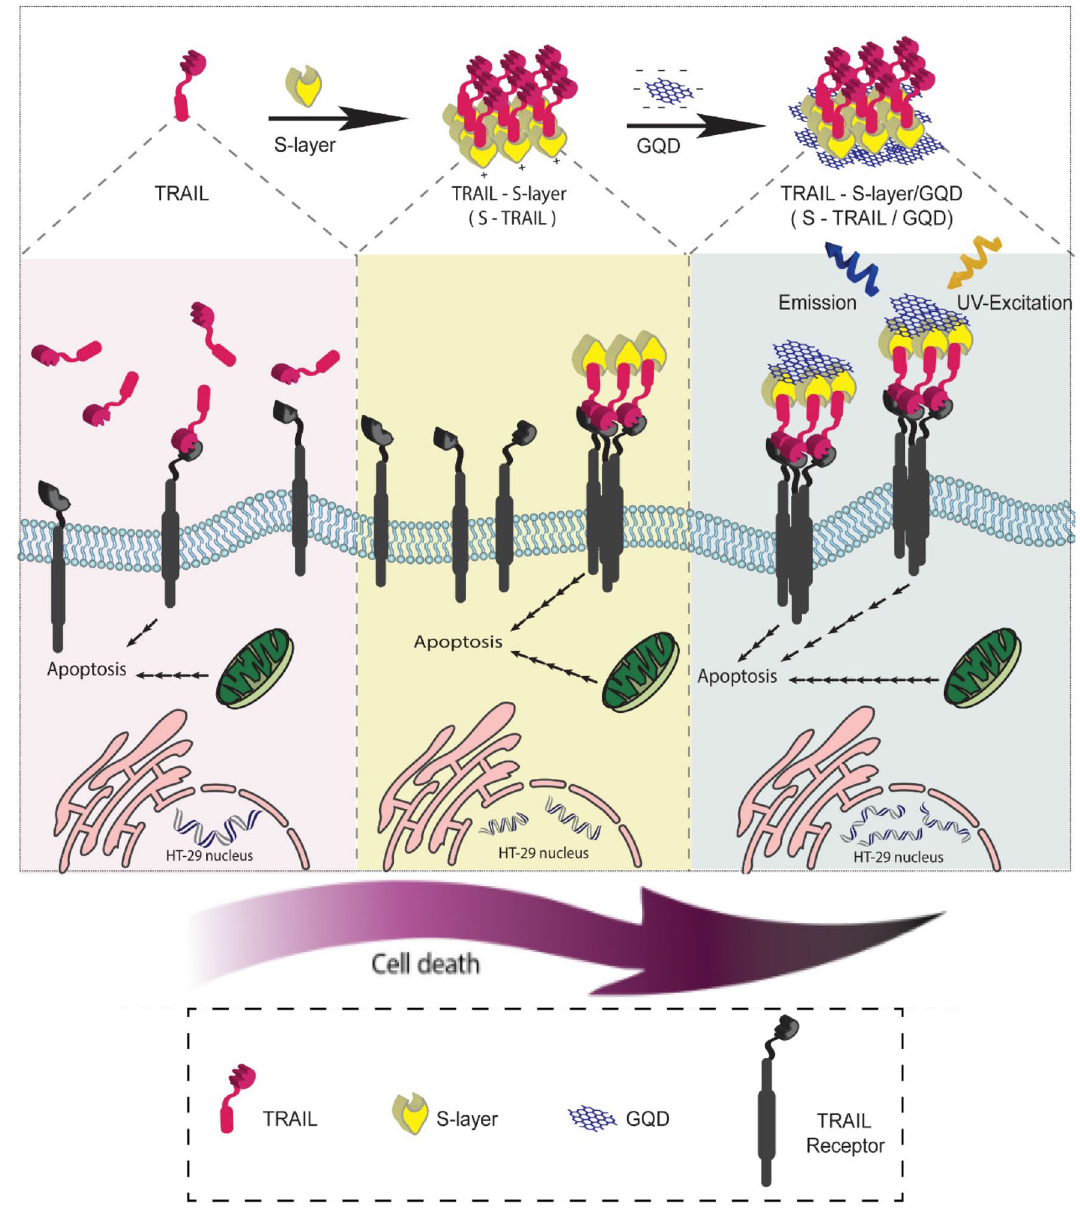
Figure 1. Schematic illustration of S-TRAIL and S-TRAIL/GQD preparation and biological